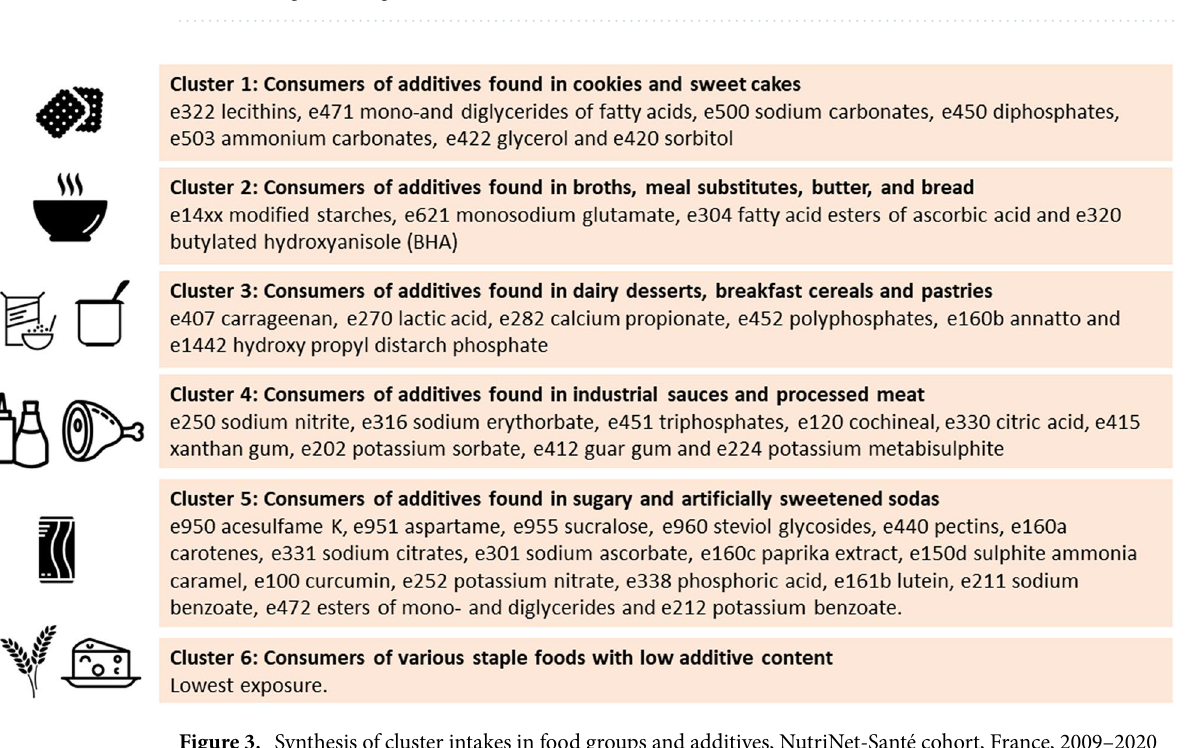
Table 4. Consumption of food groups according to clusters of food additive consumers, NutriNet-Santé cohort, France, 2009–2020 (N = 106,489). Weighted according to the French national census report data by using the CALMAR macro run by sex and based on age, socio-professional category and housing area 68 . Mean (SD), adjusted for energy intake and number of 24 h dietary records. **P values for comparisons between clusters using linear regression.